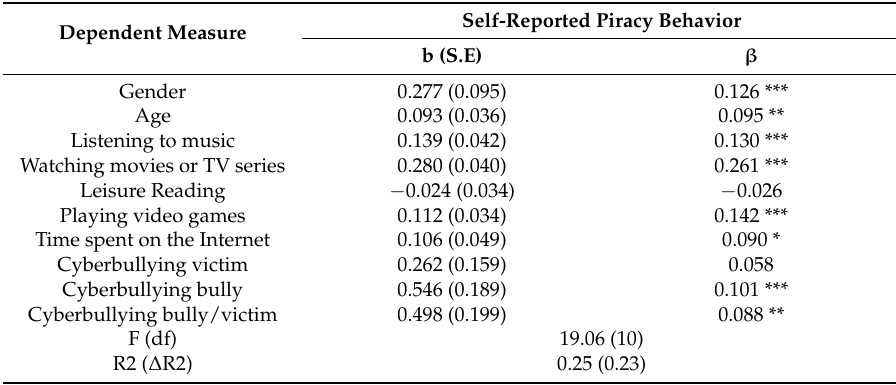
Regression analyses: associations of leisure activities, time spent on the Internet, and cyberbullying roles on self-reported piracy behavior for the whole sample.